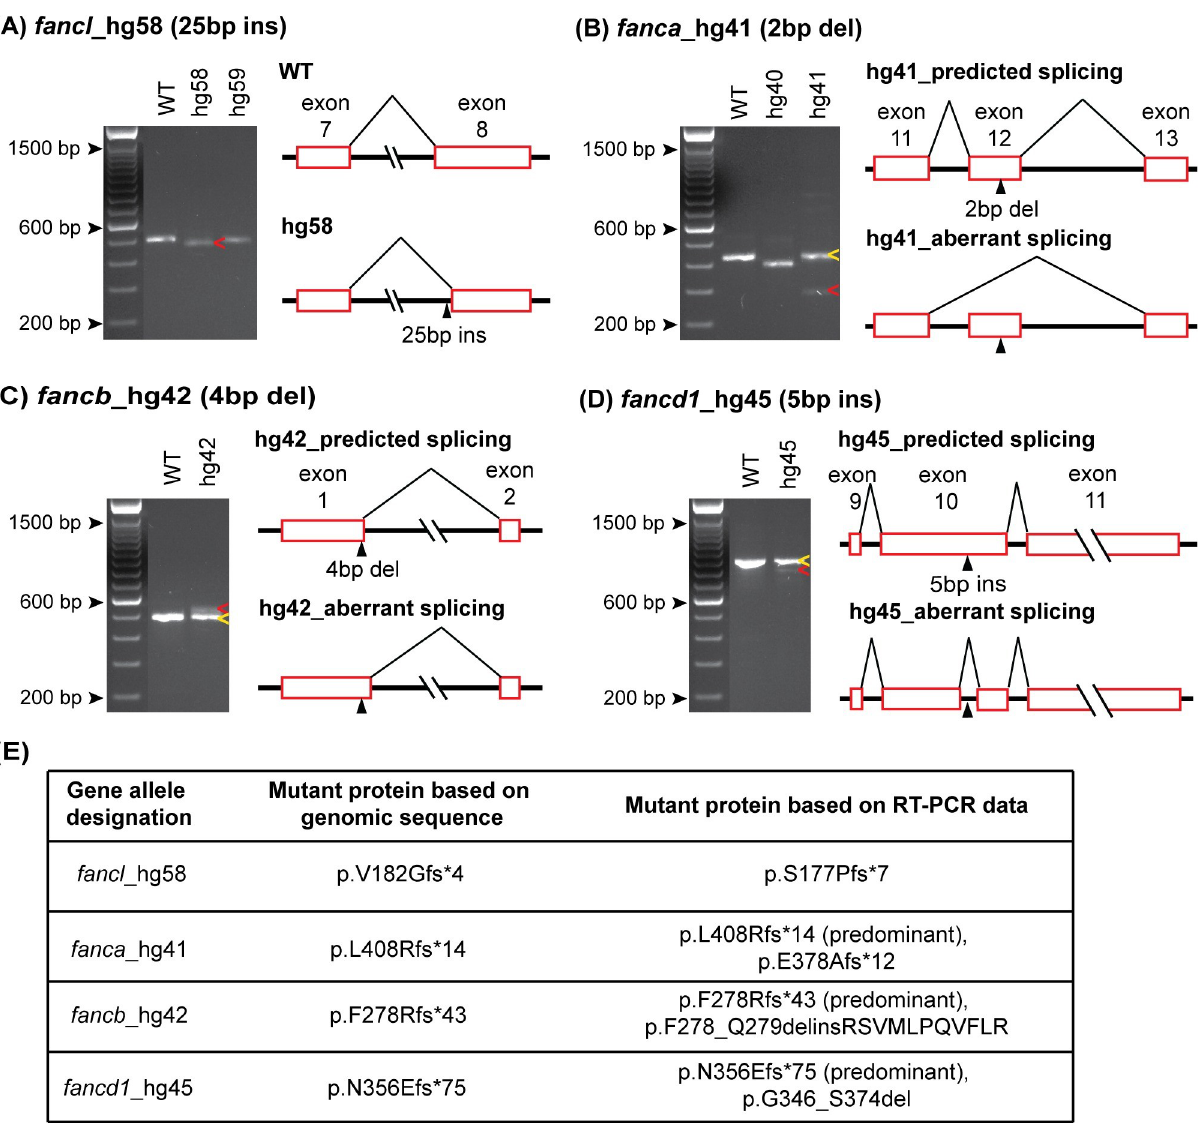
Fig 1. RT-PCR confirms indel mutations and identifies aberrant splice variants caused by CRISPR/Cas9 mutation. (A-D) WT and mutant allele RT-PCR products resolved on 2% agarose gel are shown in the left panels and splicing aberrations are depicted in the right panels. (A) The observed RT-PCR product for fancl _hg58 mutant was smaller in size (red arrow) than expected based on the 25 bp insertion in exon 8. The sequence of the hg58 product showed shift in its splice acceptor site resulting in loss of 48 bp sequence, that includes 23 bp from exon 8 beginning and CRISPR/Cas9 induced 25 bp insert. (B-D) Partial activation of cryptic splice site near the indel mutation was observed in fanca _hg41, fancb _hg42 and fancd1 _hg45 mutant alleles. The RT-PCR products for these mutants showed two bands, one matched expected size (yellow arrows) and the other was from an altered splice product (red arrows). PCR products were cloned and sequenced to determine aberrant splice product sequence. In hg41 mutant, the indel mutation (2 bp del) in exon 12 results in partial skipping of mutated exon (B). In hg42 mutant, the indel mutation (4 bp del) in exon 1 results in partial use of new splice donor site in intron 1 (C). In hg45 mutant, the indel mutation (5 bp ins) in exon 10 results in partial use of new splice acceptor and donor in exon 10 (D). (E) The consequence on the predicted encoded protein based on the genomic indel mutation, and the observed aberrant splice product for all four mutant lines are shown. RT-PCR gel image data for all 36 alleles is shown in S3A Fig.